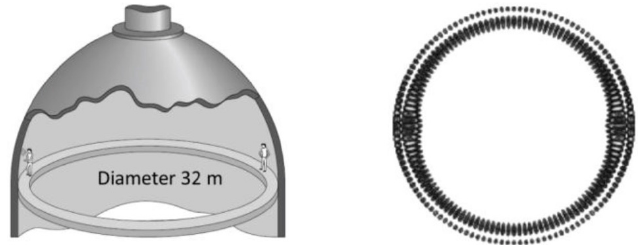
Figure 20. ( Left ) The whispering gallery under a dome of St. Paul’s cathedral and ( Right ) the sound intensity profile showing the whispering gallery mode (WGM) [148].